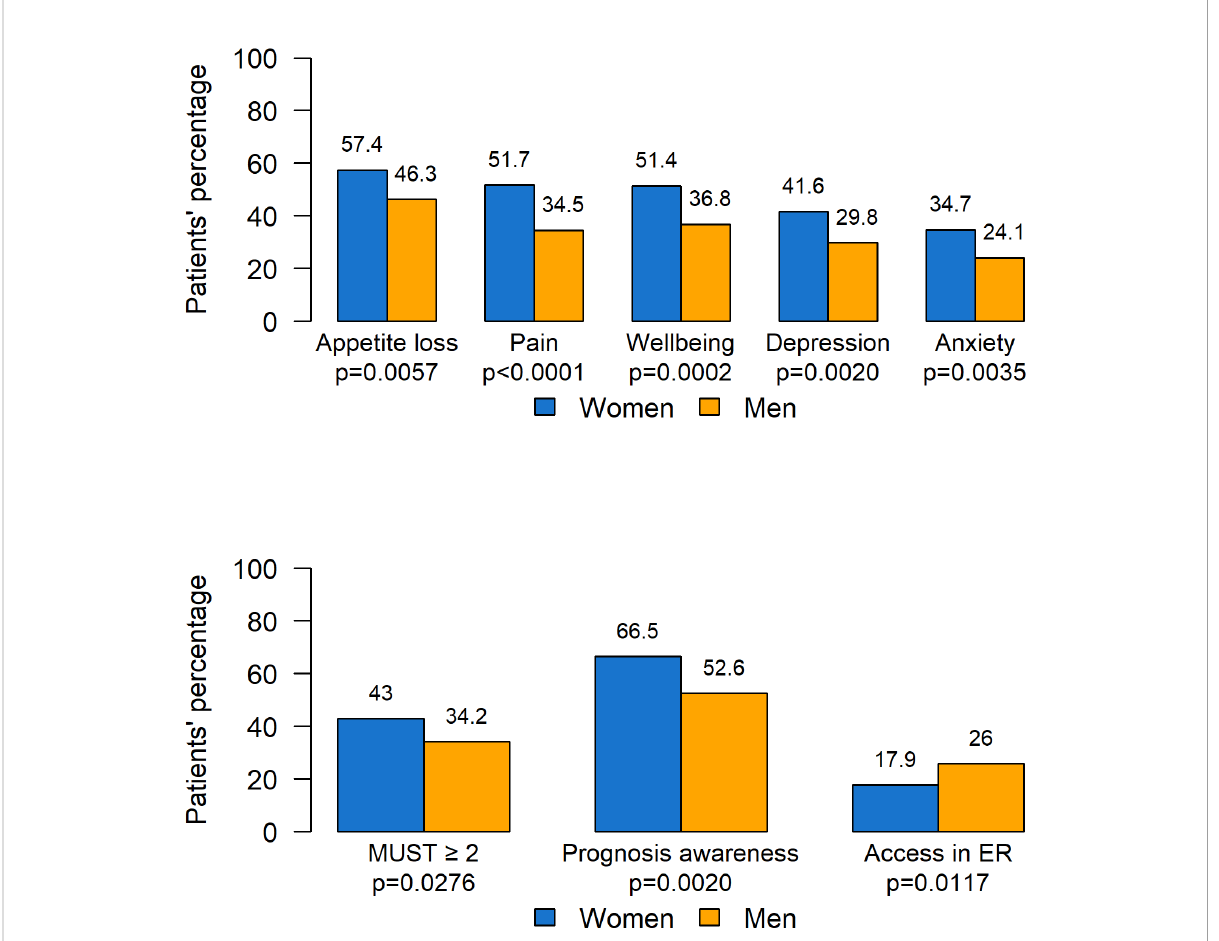
FIGURE 4 Statistically signi fi cant difference according to gender. ER, Emergency